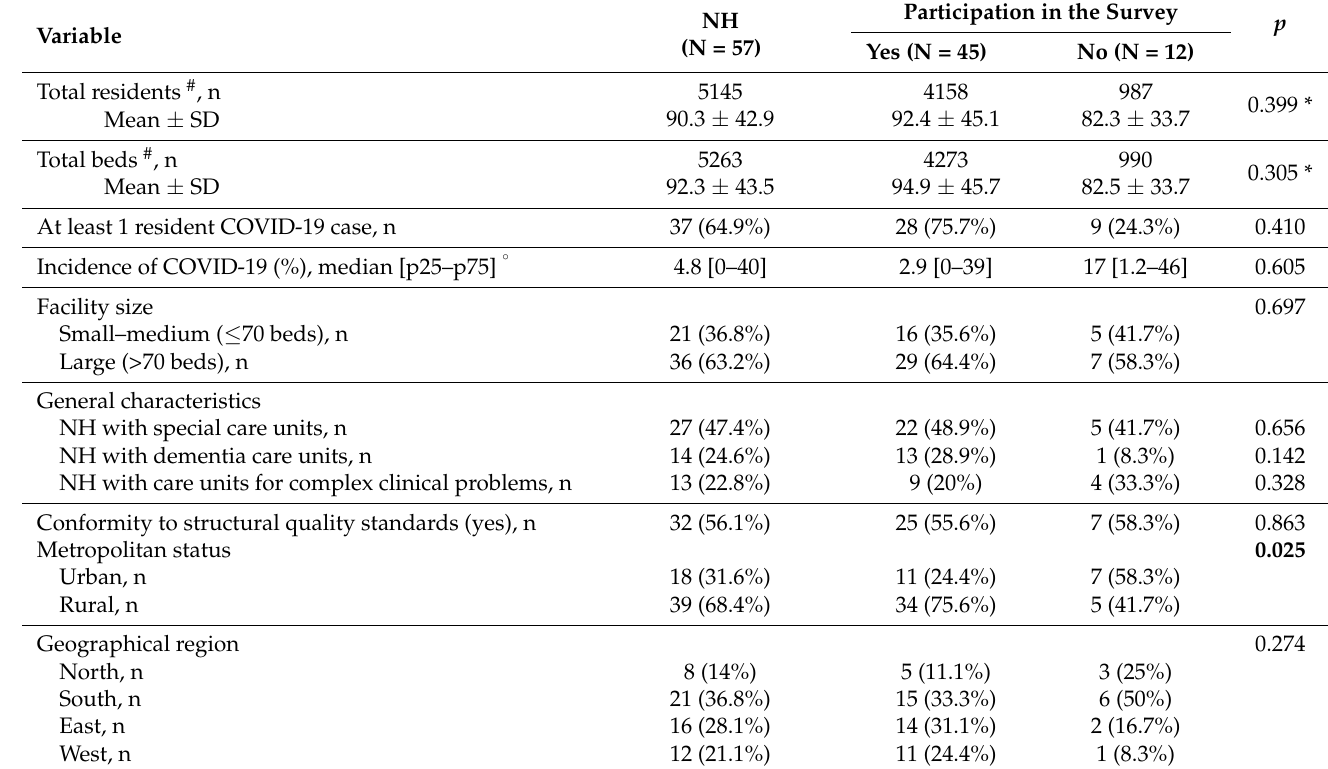
Table A1. Main characteristics of the nursing homes (NH) in the province of Trento, by participation in the infection prevention and control